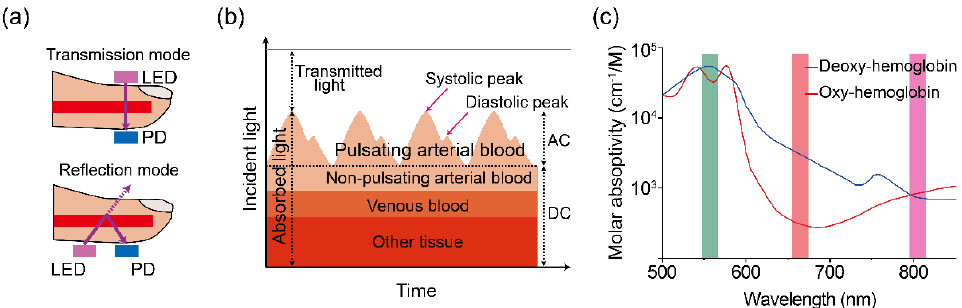
Figure 2. ( a ) Illustration of a two-mode (transmission and reflection) PPG sensor. ( b ) Variation in tissue light attenuation. ( c ) Molar absorptivity of oxygenated (blue line) and deoxygenated (red line) hemoglobin in arterial blood as of wavelength. Reproduced with permission from [50,51], ELSEVIER (1997) and SPIE (1999).